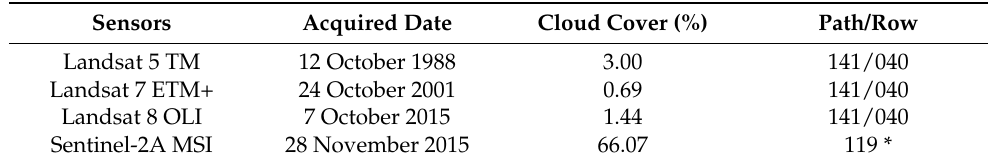
Table 5. Detailed information of images from four different